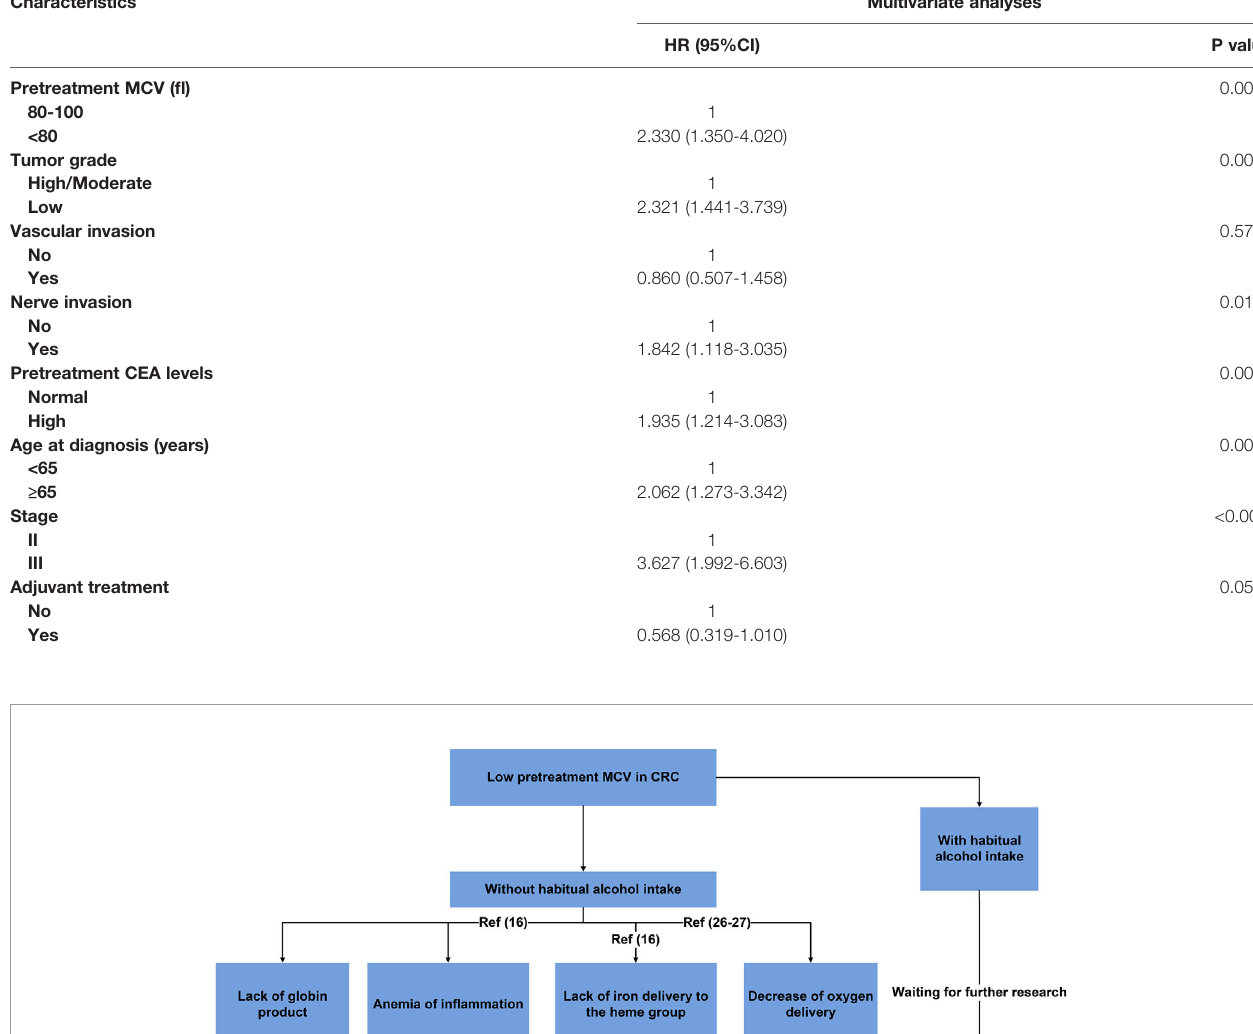
TABLE 3 | Multivariate Cox regression analyses for OS in patients without habitual alcohol intake.